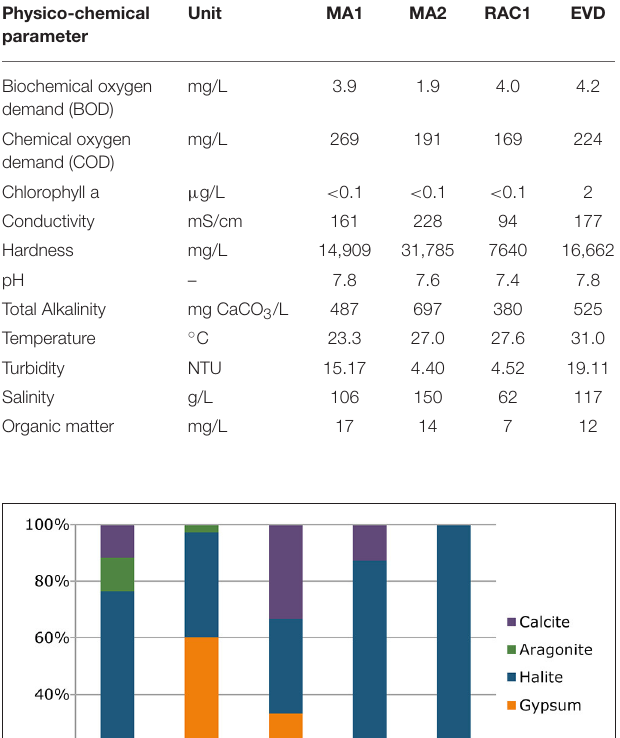
TABLE 1 | Physico-chemical parameters for the overlying water from the different samples studied. Physico-chemical parameter